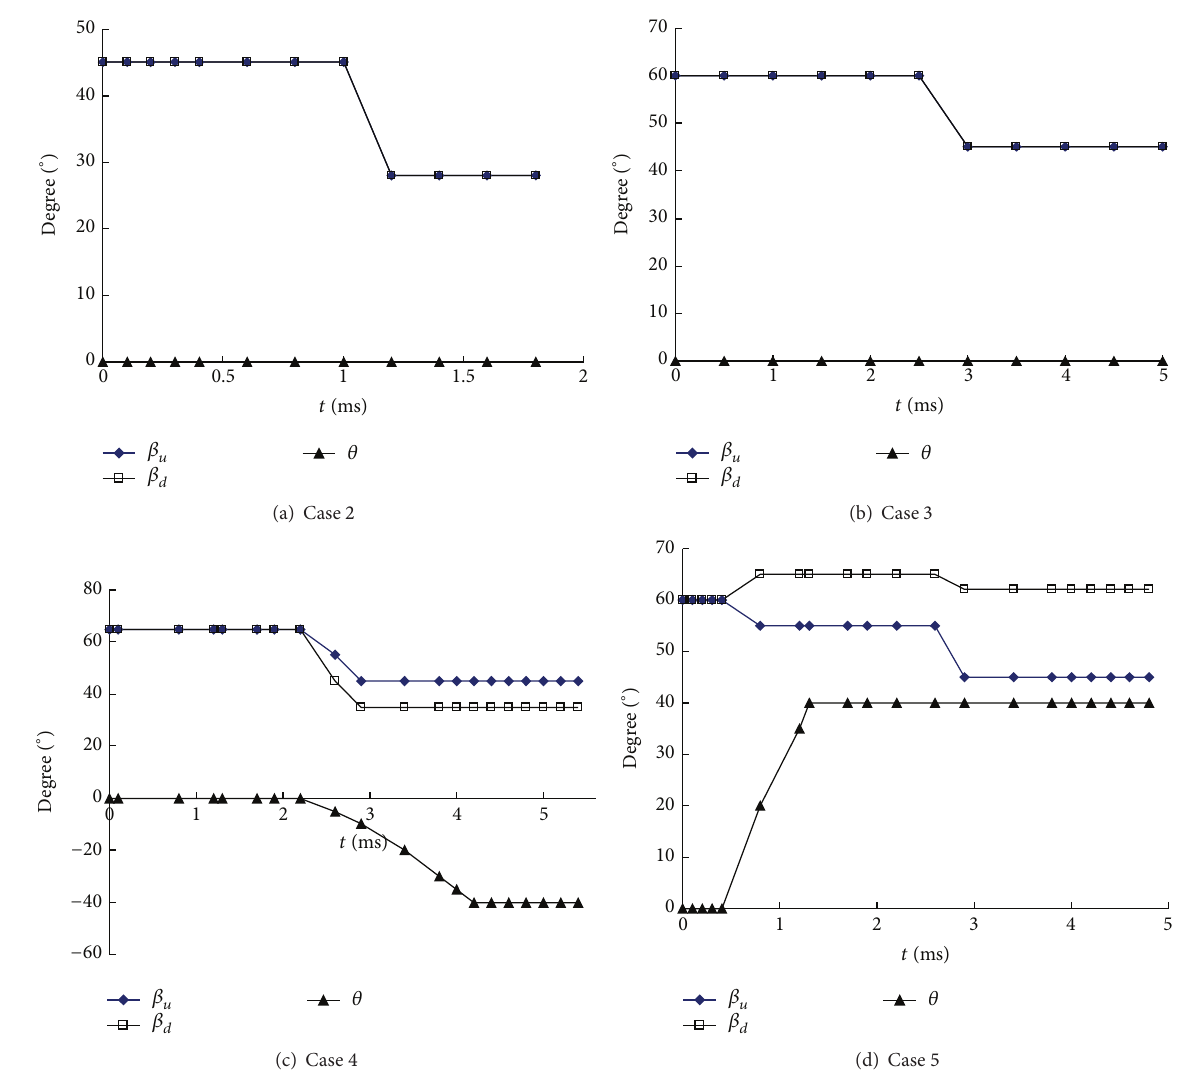
Figure 12: The contact angle degree curve in different